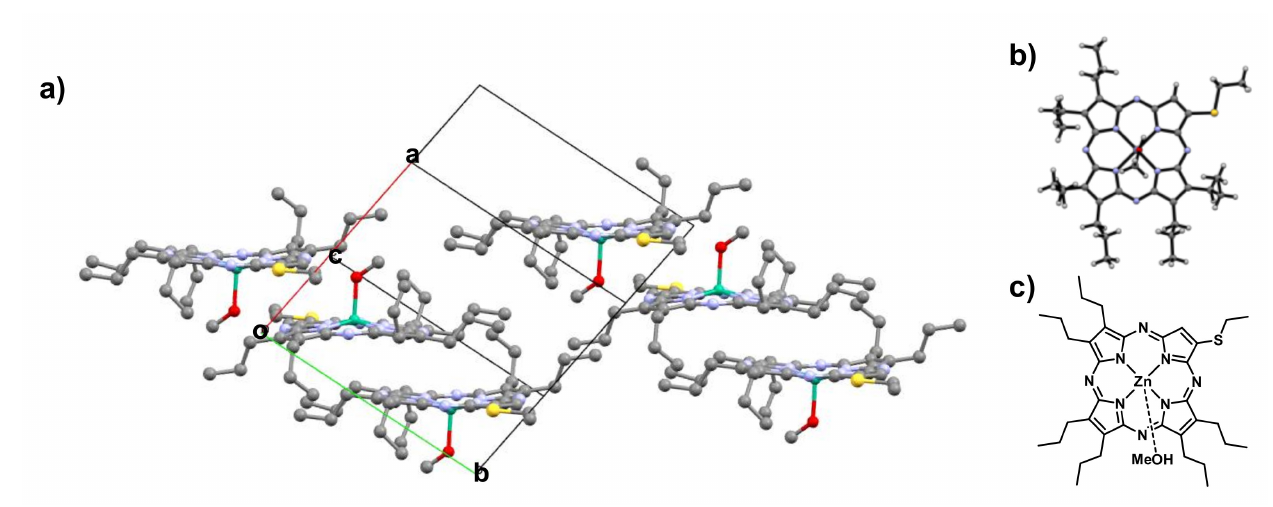
Figure 2. ( a ) Crystal structure of ZnPz 5 , including the unity cell. ( b ) Top view of ZnPz 5 . ( c ) Schematic representation of ZnPz 5